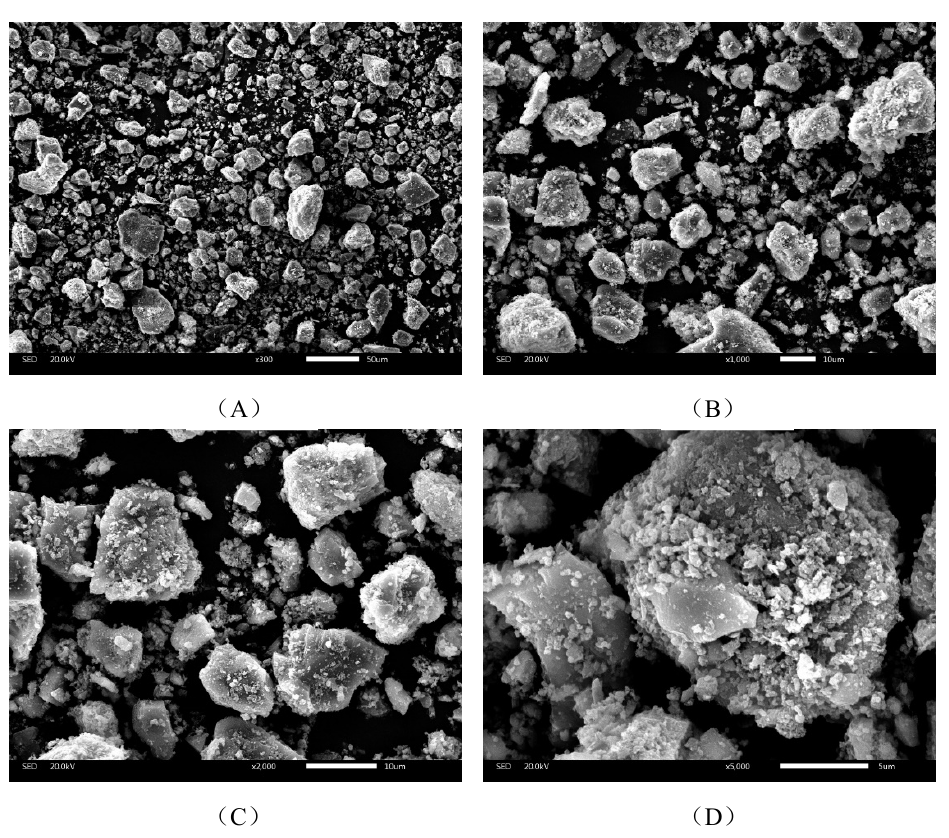
Figure 4. SEM images of phosphorus tailing micro-powder under different magnification: ( A ) 300 times, ( B ) 1000 times, ( C ) 2000 times, and ( D ) 5000 times.